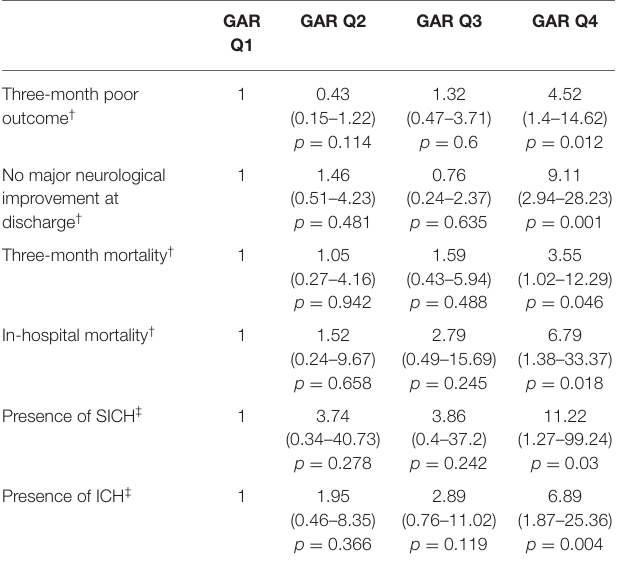
TABLE 3 | Logistic regression model: adjusted ORs (95% CIs) of the GAR quartiles in relation to the respective